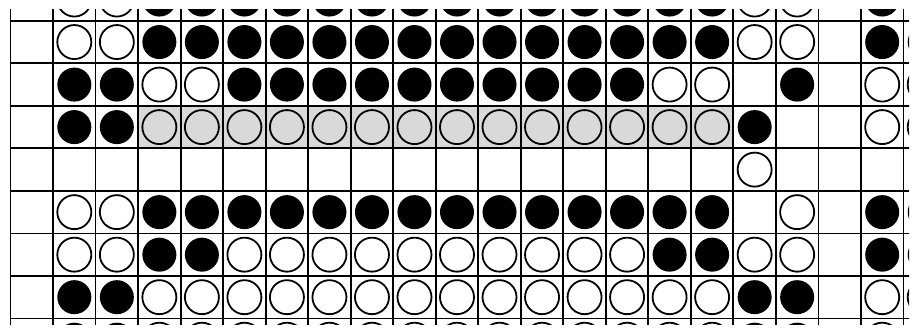
Figure 14. BLACK